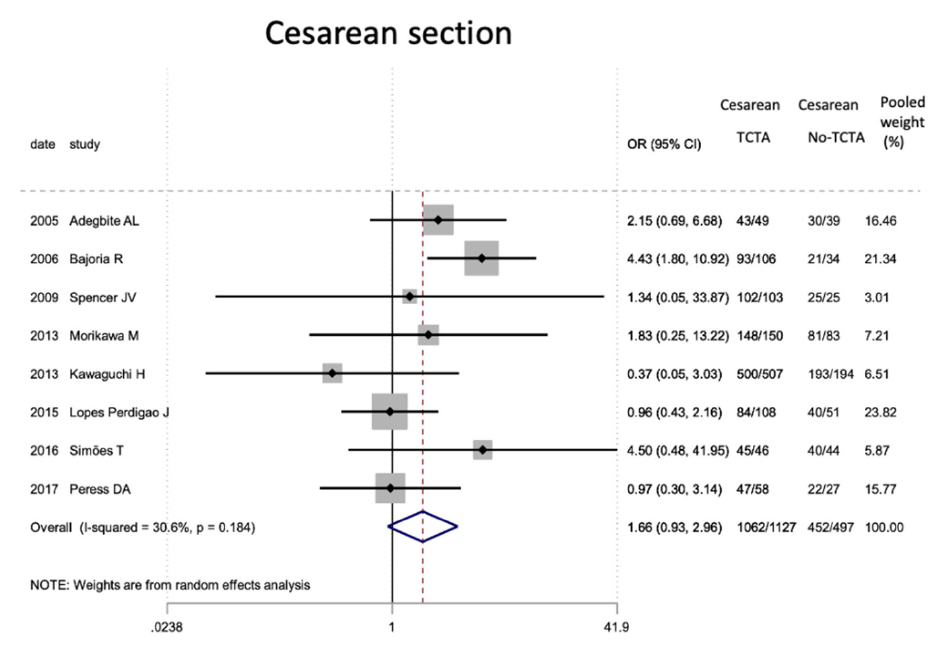
Figure 3. Results of the meta-analysis on the effect of chorionicity (TCTA vs no TCTA) on cesarean as the mode of delivery. TCTA: trichorial-triamniotic, non-TCTA: non-trichorial-triamniotic. OR = odds ratio, CI = confidence interval.